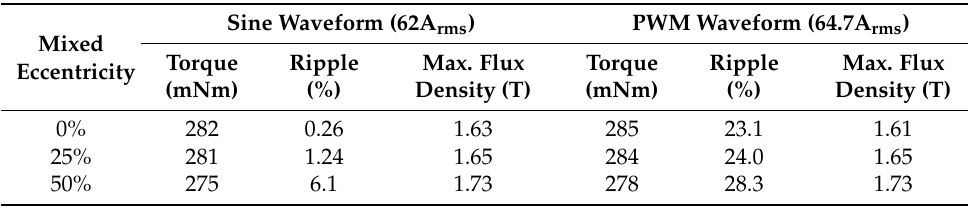
Figure 8. Concept of forced vibration (electromagnetic-structural one-way coupled) analysis.